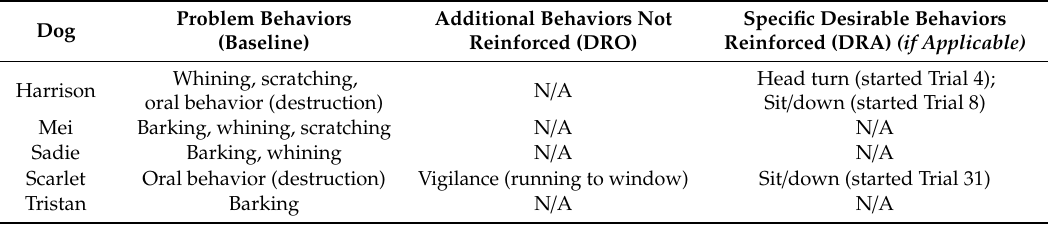
Table 4. Target behaviors. Problem behaviors identified from Baseline for each dog and other behaviors that were not problem behaviors but were undesirable and would not be reinforced during di ff erential reinforcement of other behavior (DRO). Specific desirable behaviors reinforced in a DRA for Harrison and